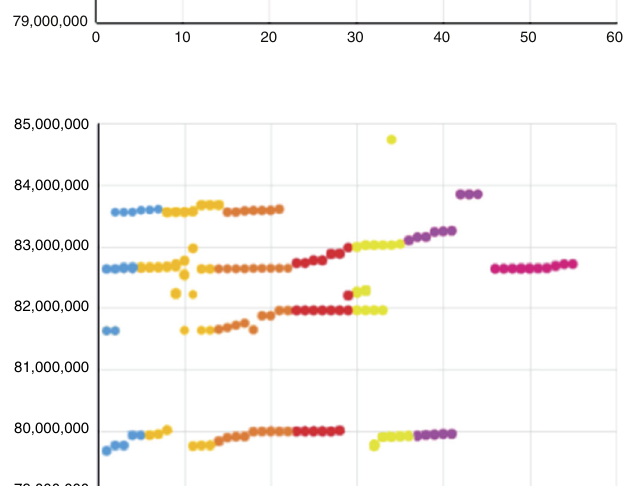
Figure 17. Result of DBSCAN on “ MOOCs ” data set